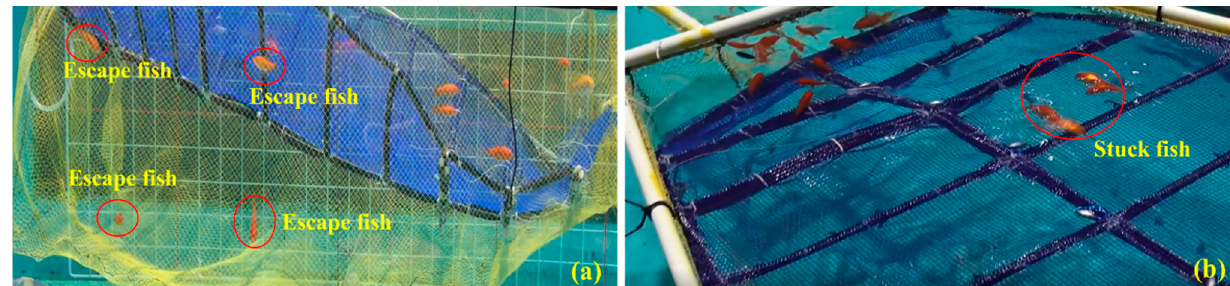
Figure 14. ( a ) Fish escaped through the gaps. ( b ) Fish stuck on the hose net and unable to swim